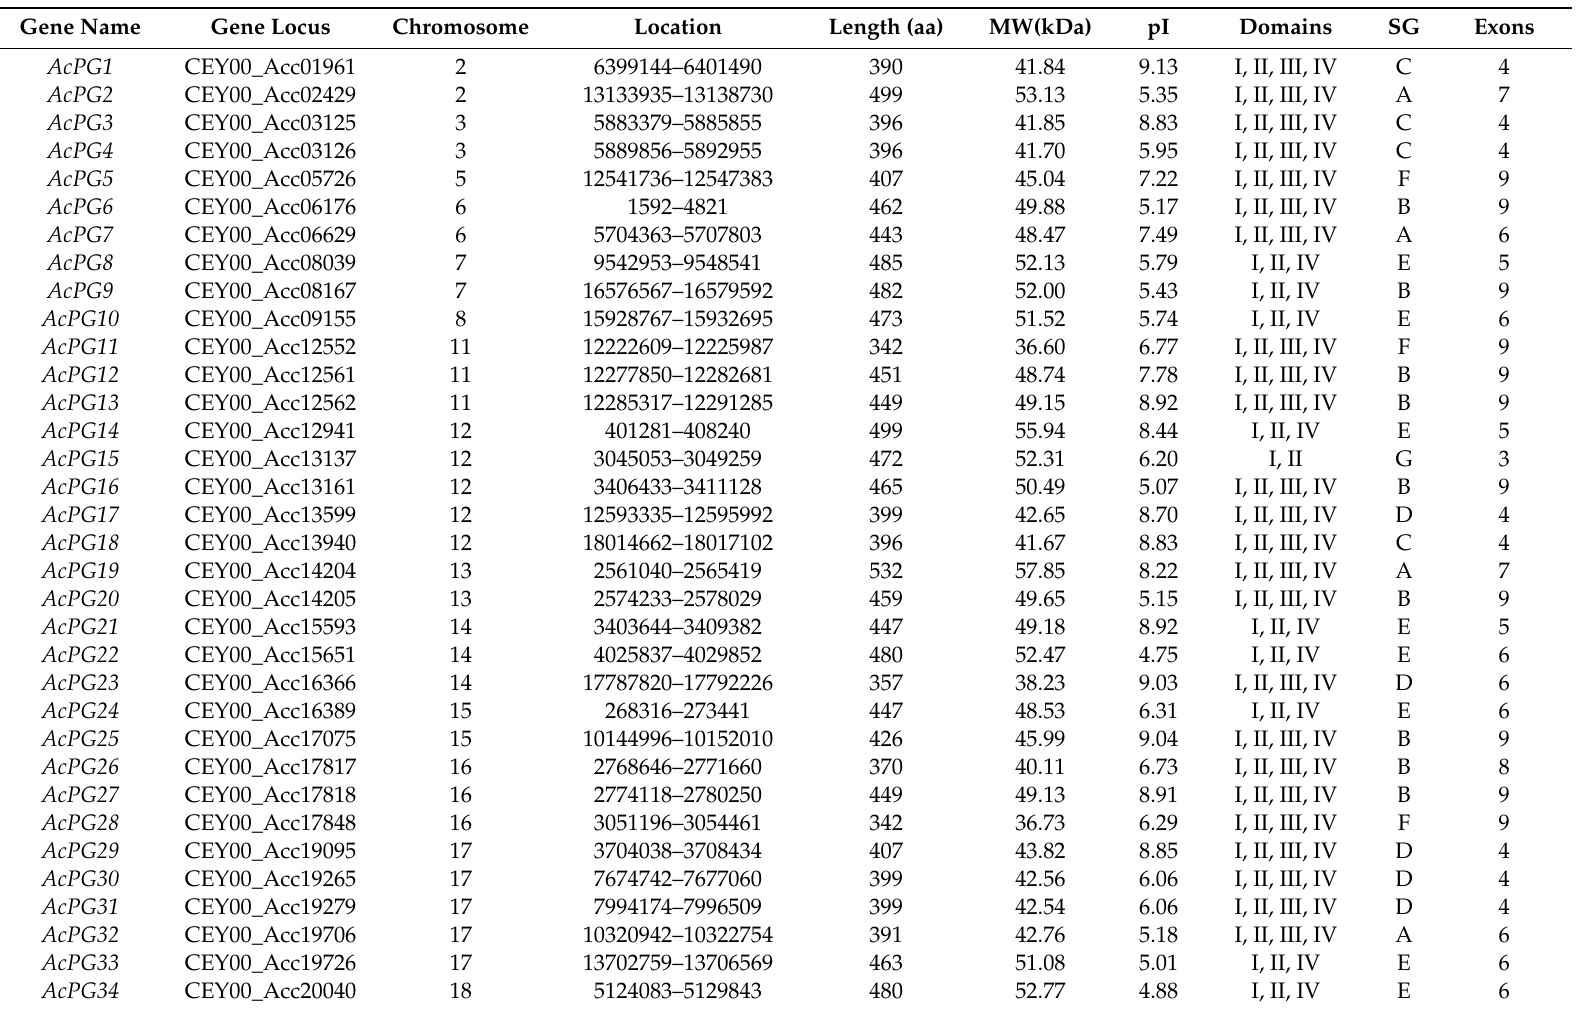
Table 1. Summary of PG gene family members identified in